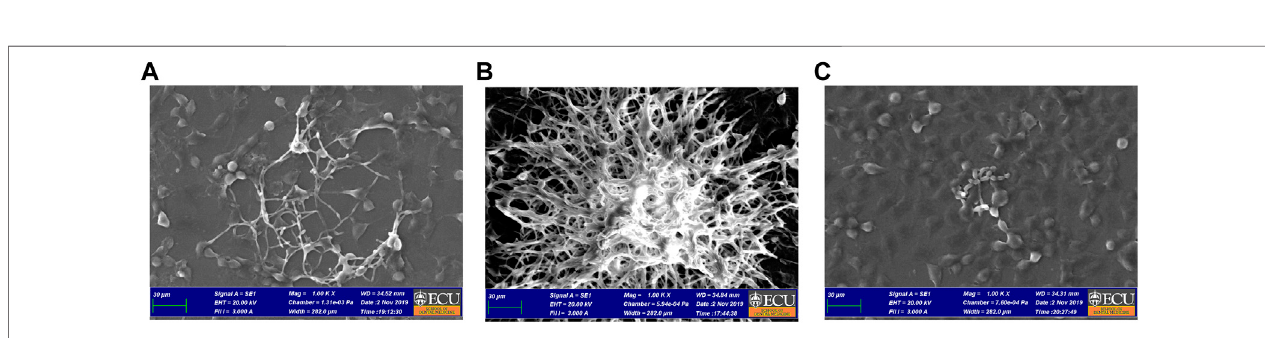
FIGURE 6 | Co-culture SEM after 24 h of treatment with A. colubrina extract. (A) A. colubrina extract (33.28 μ g/ml); (B) Vehicle control (DMSO 0.1%) and (C) positive control (Fluconazole – 10 μ g/ml). Scale bar set at 30 μ m at 1,000x magni fi cation power.